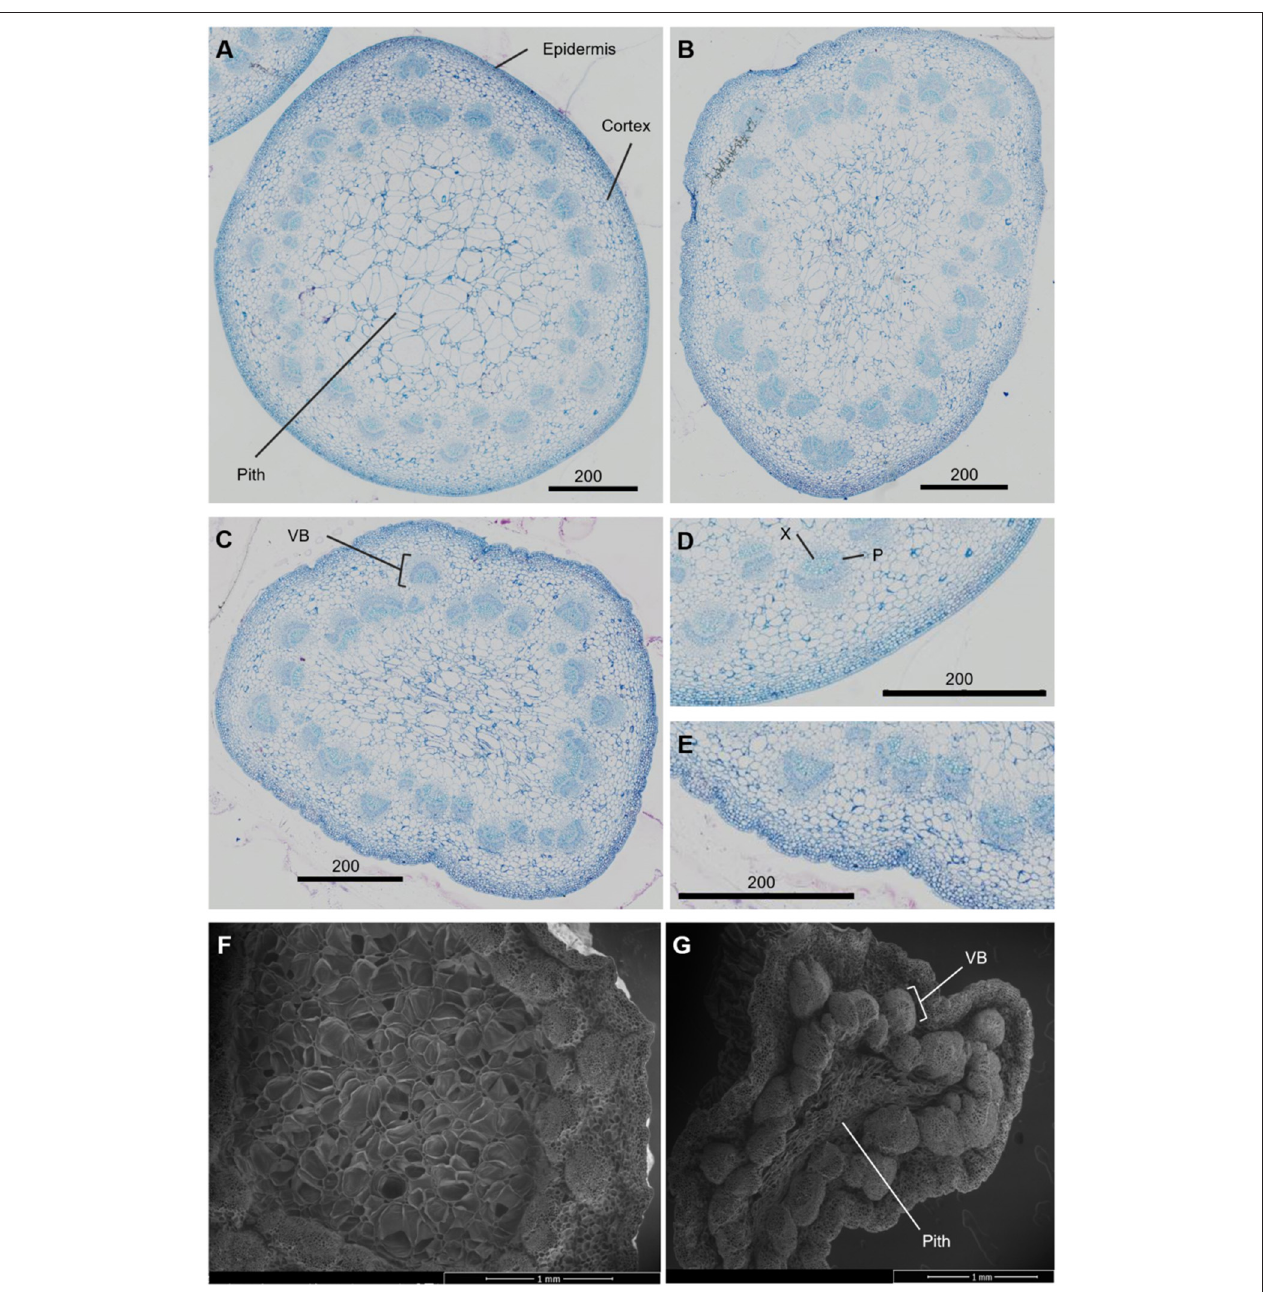
FIGURE 2 | Transverse sections of Rosa hybrida cv. H30 peduncles. Light microscopy images stained with toluidine blue at 40x magnification of necking stages: straight (A) , < 90 ◦ (B) and > 90 ◦ (C) ; epidermis of straight (D) , and > 90 ◦ peduncles (E) . Electron microscopy images of Straight (F) and > 90 ◦ (G) necking peduncles at 50 x magnification. VB, vascular bundles; X, xylem; P, phloem.